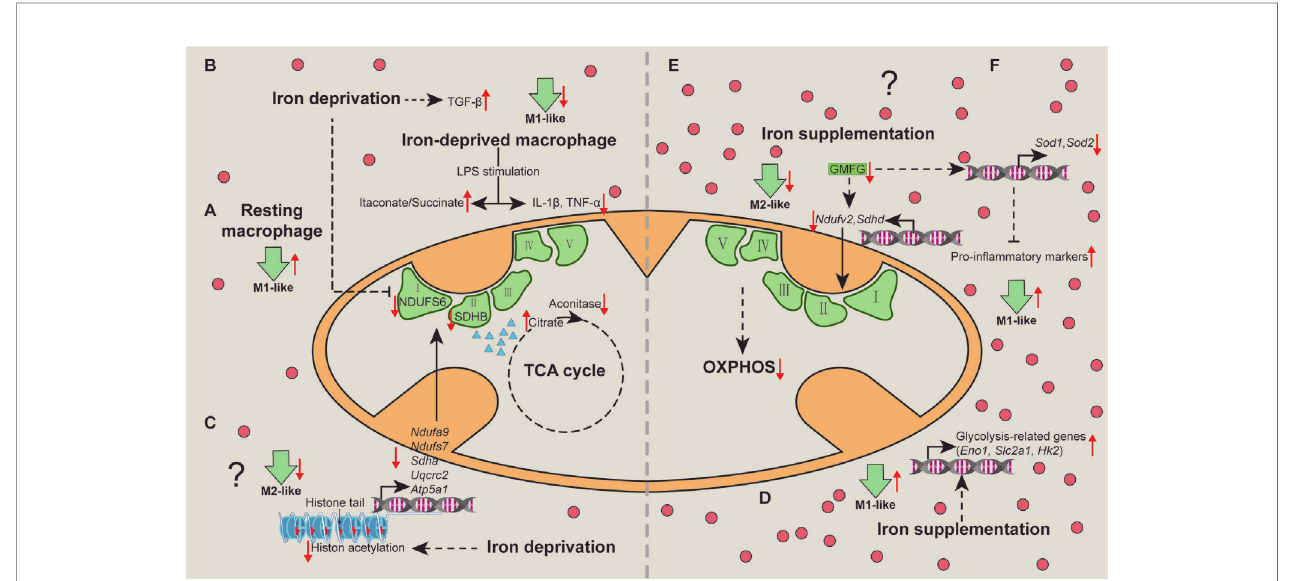
FIGURE 2 | Mechanisms associated with metabolic pathways whereby iron shapes macrophage polarization. Iron deprivation directly inhibits the expression of NDUFS6 and SDHB and blocks the activity of mitochondrial aconitase to cause citrate accumulation, thereby switching resting macrophages towards M1-like macrophages (A) . Iron deprivation limits M1 polarization by increasing itaconate:succinate ratio through altering metabolic fl uxes and inducing TGF- b signaling pathway (B) . Specially, iron deprivation decreases histone acetylation to reduce transcription of the nuclear DNA-encoded OXPHOS genes, suppressing M2-like phenotype (C) . Iron-load increases the expressions of glycolysis-related genes to promote glycolysis in macrophages, enhancing M1-like macrophage polarization (D) . Iron might restrain M2-like macrophage, while favors M1-like macrophage polarization via reducing the expression of NDUFV2 and SDHD (E) , and SOD1 and SOD2 through down-regulating GMFG (F) , respectively. OXPHOS, oxidative phosphorylation; TGF- b , transforming growth factor- b . “ ↑ ” , increase; “ ↓ ” , decrease. Question mark means that the mechanism needs experimental con fi